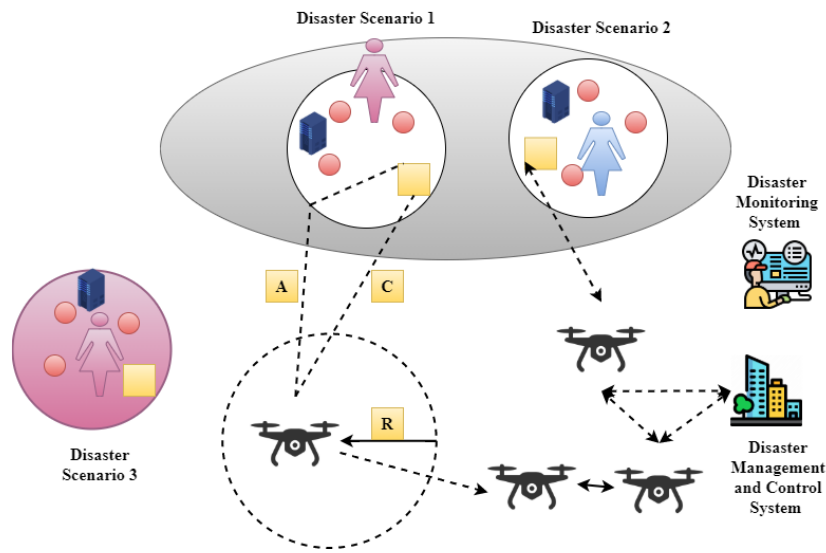
Figure 5. IoT-based Disaster Monitoring System.